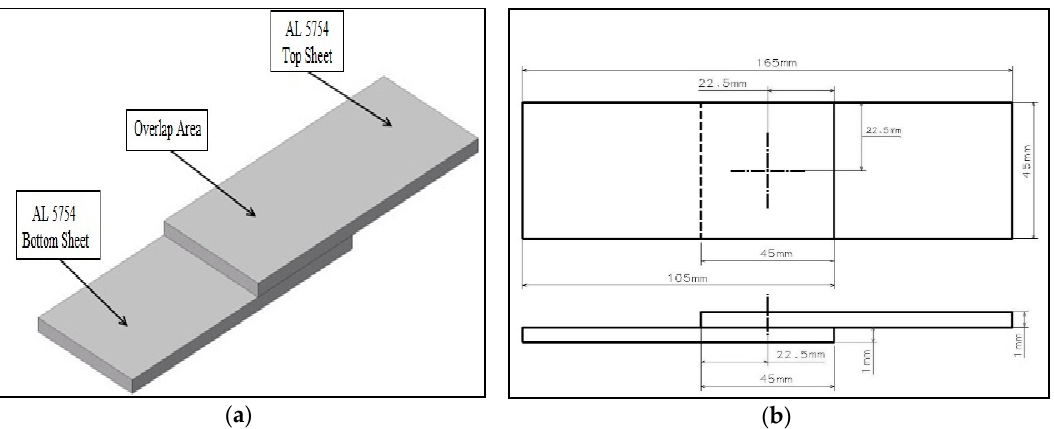
Figure 3. ( a ) The isometric view for welding position of the samples. ( b ) The dimension of the top view and the side view for the welding position of the samples.